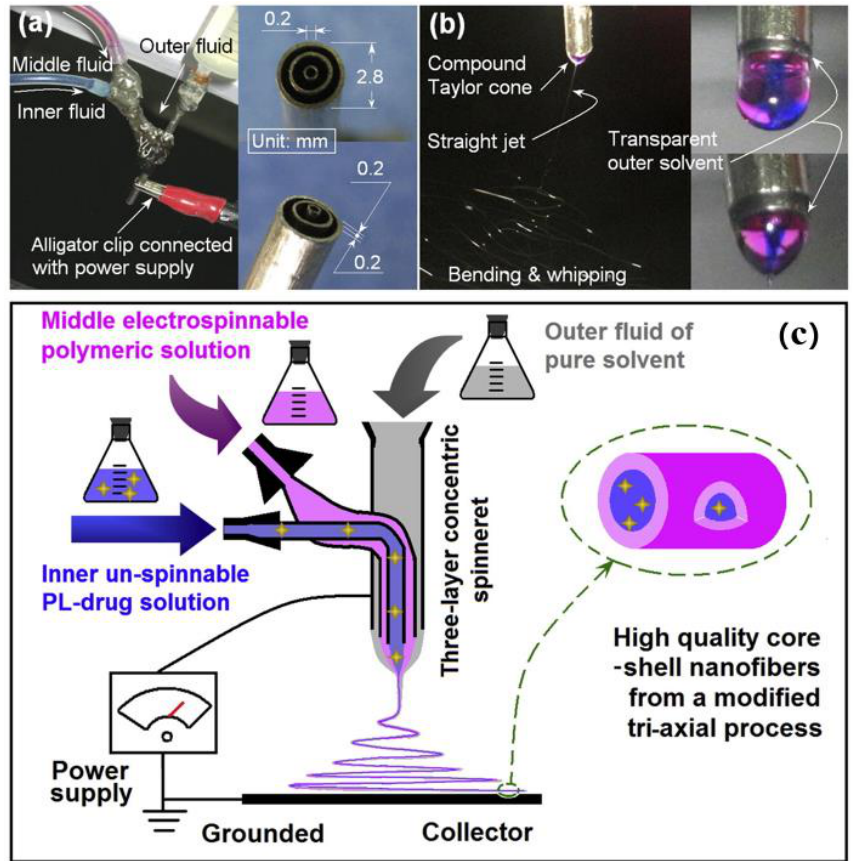
Figure 5. Modified triaxial electrospinning. Adapted with permission from [103]. Copyright, 2016 Elsevier. ( a ) spinneret connections to power and working fluid ( left ), and spinneret image (inset); ( b ) digital photograph of the triaxial process ( left ), droplet ( upper right ), and compound Taylor cone ( lower right ) before application of 15 kV voltage; ( c ) modified triaxial electrostatic spinning process and its use in the preparation of core–shell drug-loaded